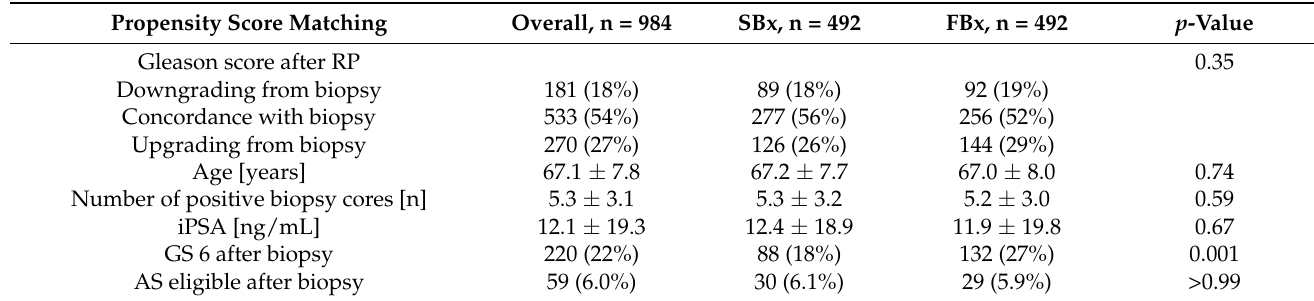
Table 2. Baseline characteristics of patients undergoing FBx versus SBx. Values are presented as mean ± standard deviation or n (%). The t -test was performed for comparisons between continuous variables and the chi-squared test between categorical variables. AS: active surveillance, GS: Gleason score, iPSA: prostate-specific antigen at FBx, RP: radical prostatectomy.